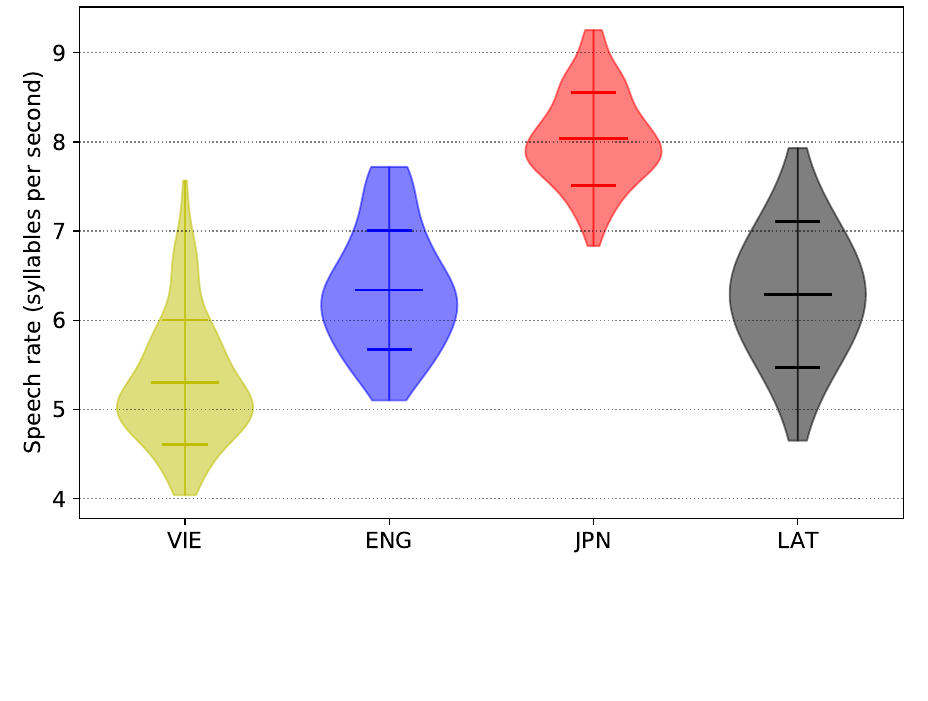
Figure 6. Our reconstructed speech rate for Classical Latin, compared to measured speech rates of living languages: Vietnamese, English, and Japanese